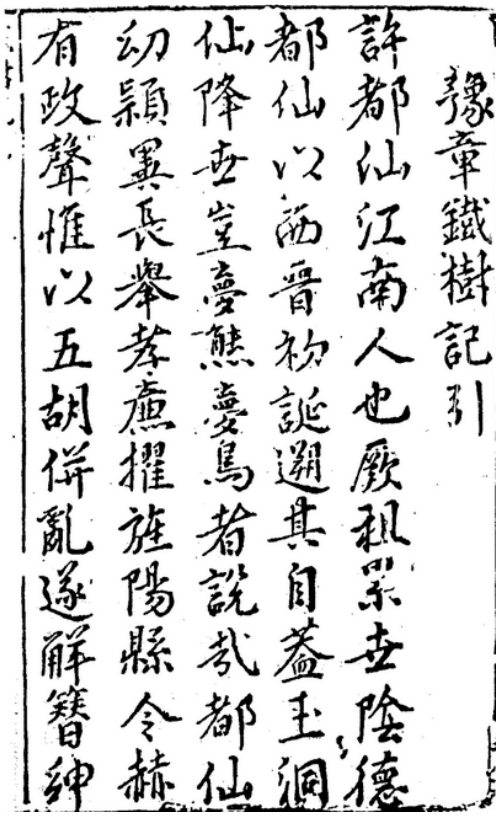
Figure 1. The first page of Deng Zhimo’s preface to The Iron Tree , 1603.